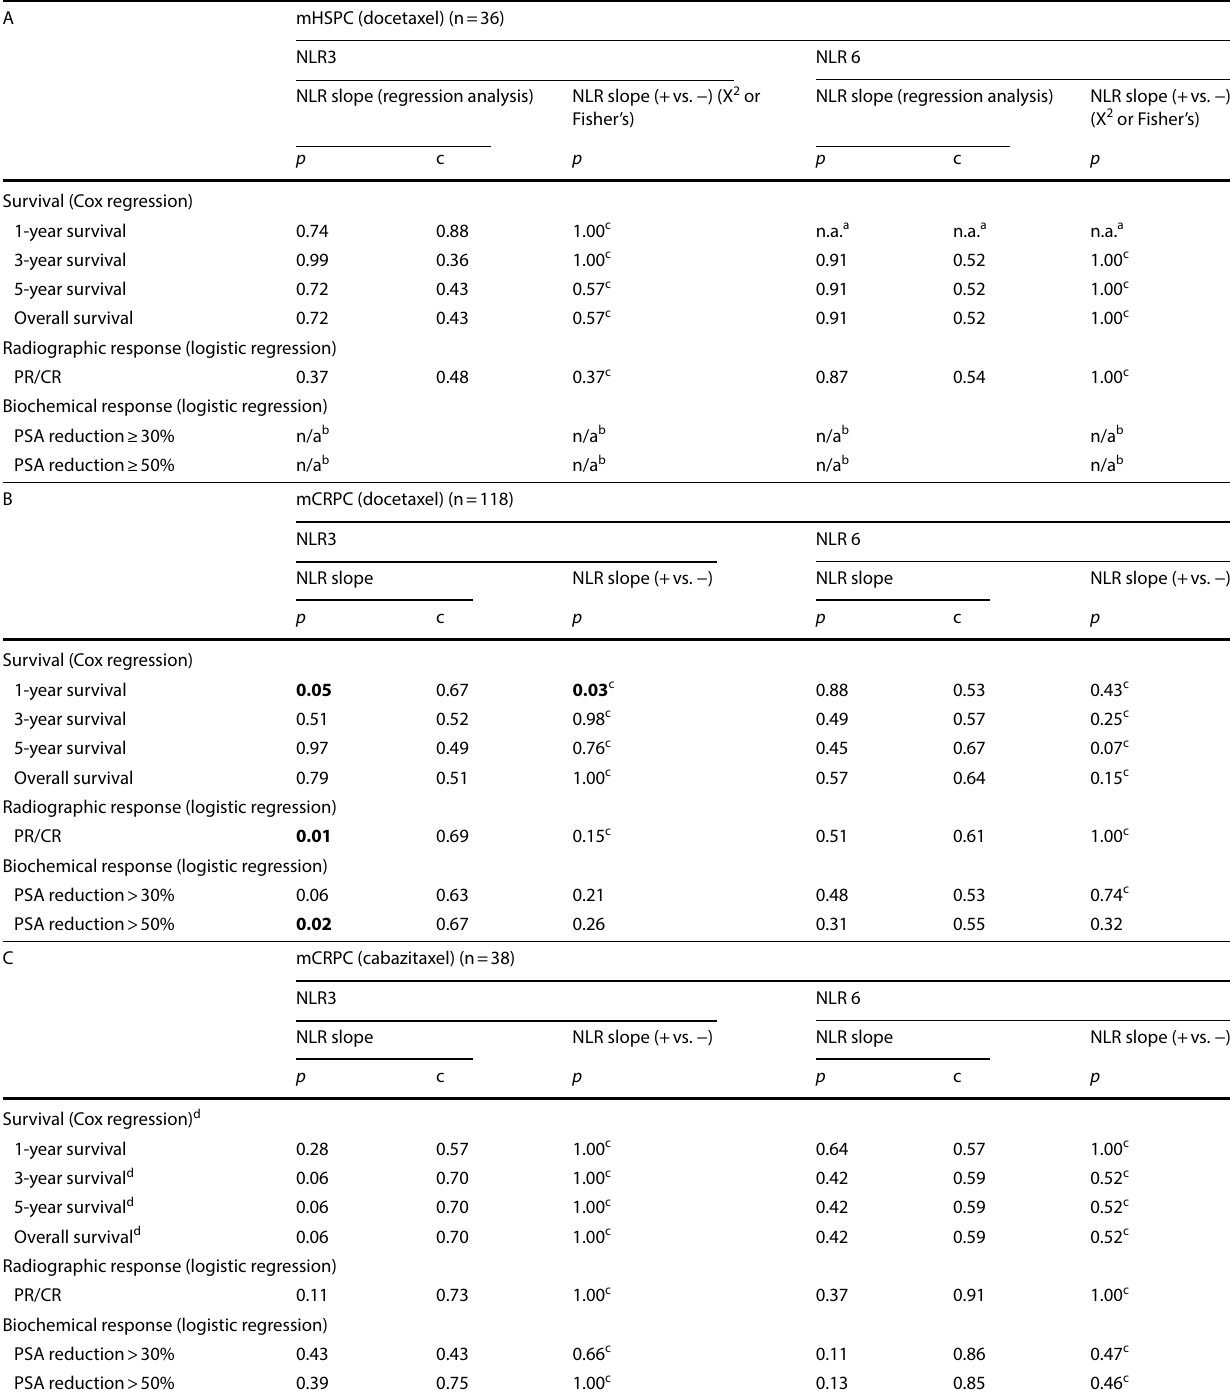
Table 2 Logistic regression and X 2 or Fisher’s exact tests of NLR slopes over 3 (NLR3) and 6 (NLR6) cycles in the different cohorts A mHSPC cohort treated with docetaxel B mCRPC cohort treated with docetaxel C mCRPC cohort treated with